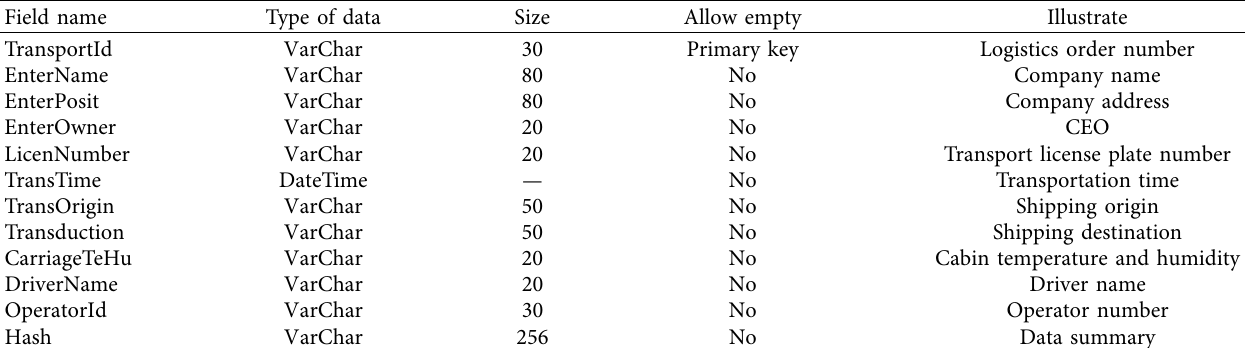
Table 5: Logistics and transportation information